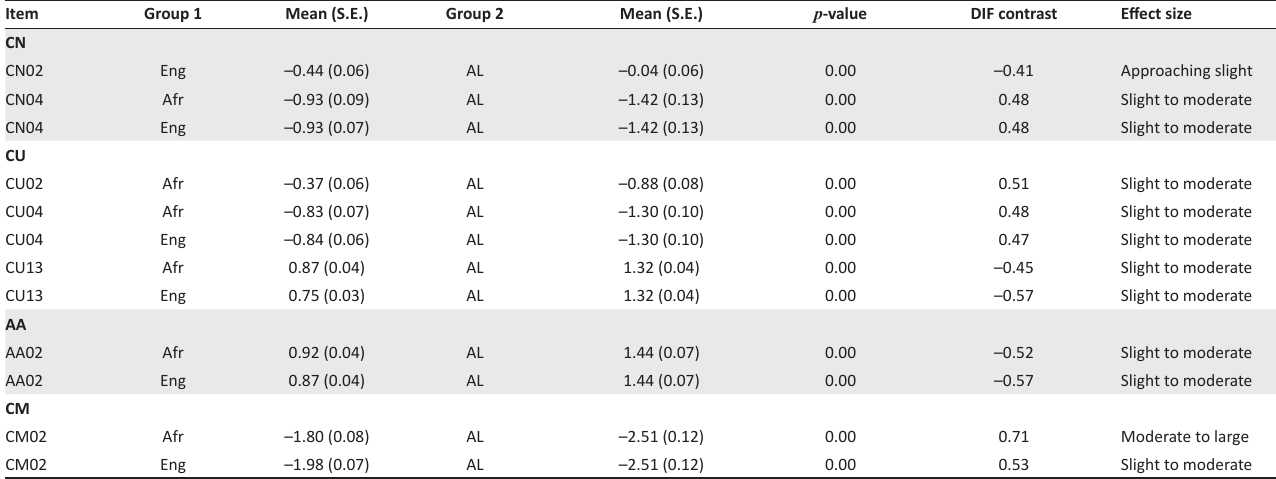
TABLE 7: Differential item functioning between language